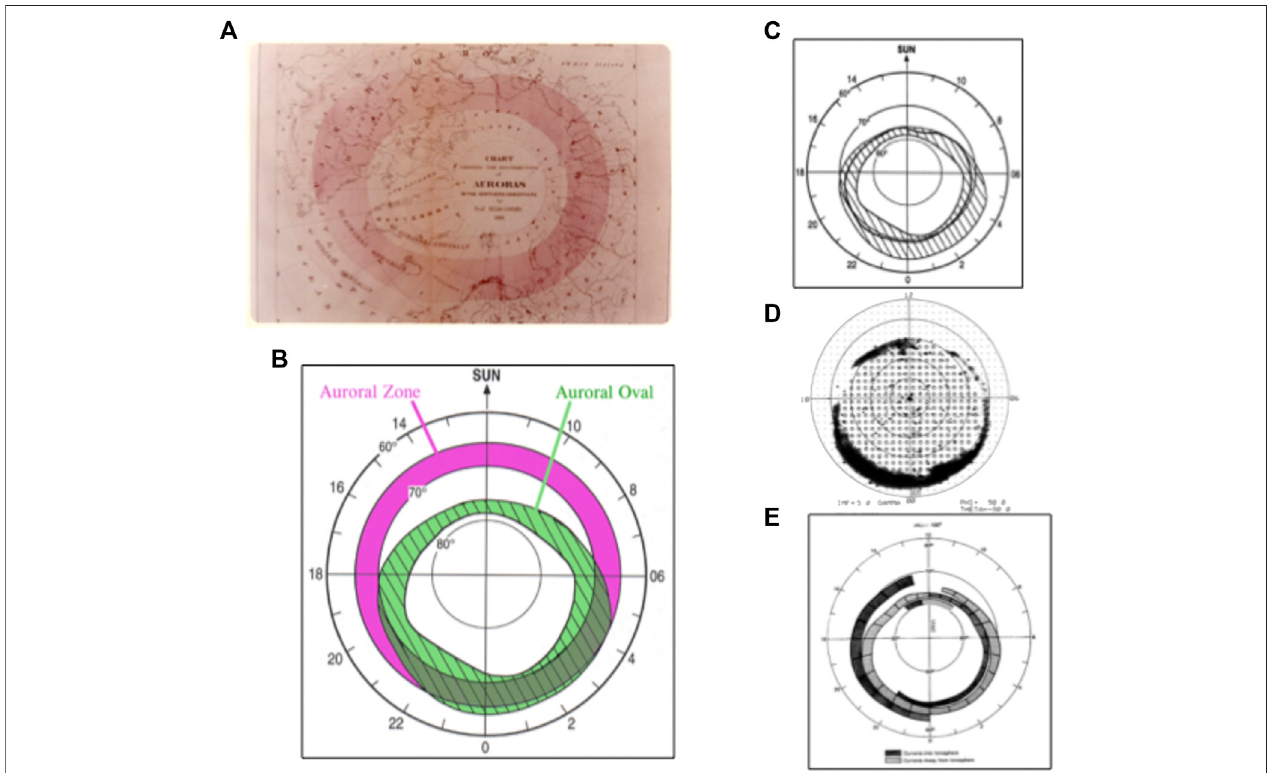
FIGURE 6 | (A) Loomis ’ auroral zone. (B) Comparison of the auroral zone (pink) and Feldstein ’ s oval (green). (C) The comparison of the auroral oval and the intersection linebetween theouter boundary of the outer Van Allen belt, Akasofu (University ofIowa, Departmentof Physics Report). (D) The auroral ovaland the “ roots ” of the linked fi eld lines. (E) The distribution of the fi eld-aligned current (Iijima et al.,